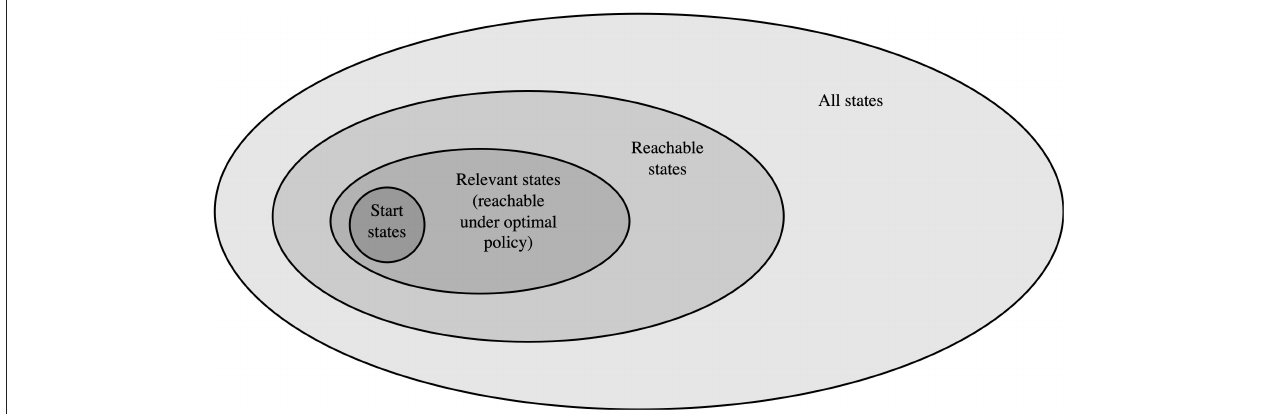
FIGURE 3 | Venn diagram of total state space. Only a subset of the entire state space is reachable from the start state under any policy . An even smaller subset of the reachable set is eventually relevant , in the sense that they are reachable from the start state under the optimal policy . Finally, a subset of the relevant state are of course all start states. Figure extended from Sutton and Barto